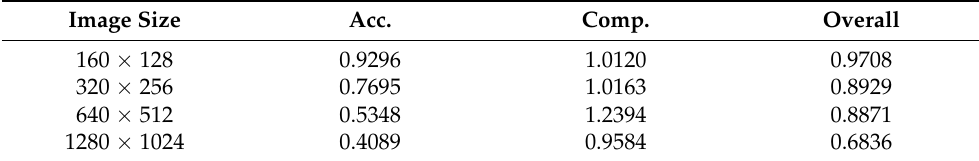
Table 6. Results on different resolution images. Image